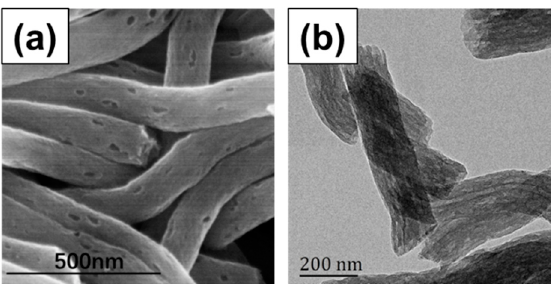
Figure 3. ( a ) SEM and ( b ) TEM images of PCNFs.